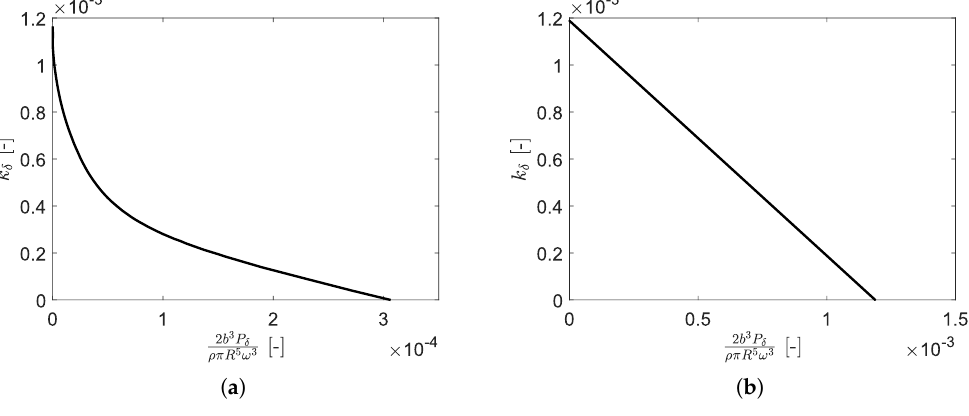
(cid:16) (cid:17) 2 b 3 P δ Figure 12. k δ tables for NREL 5-MW ( a ) and DTU-10 MW ( b ) reference turbines. ρπ R 5 ω 3